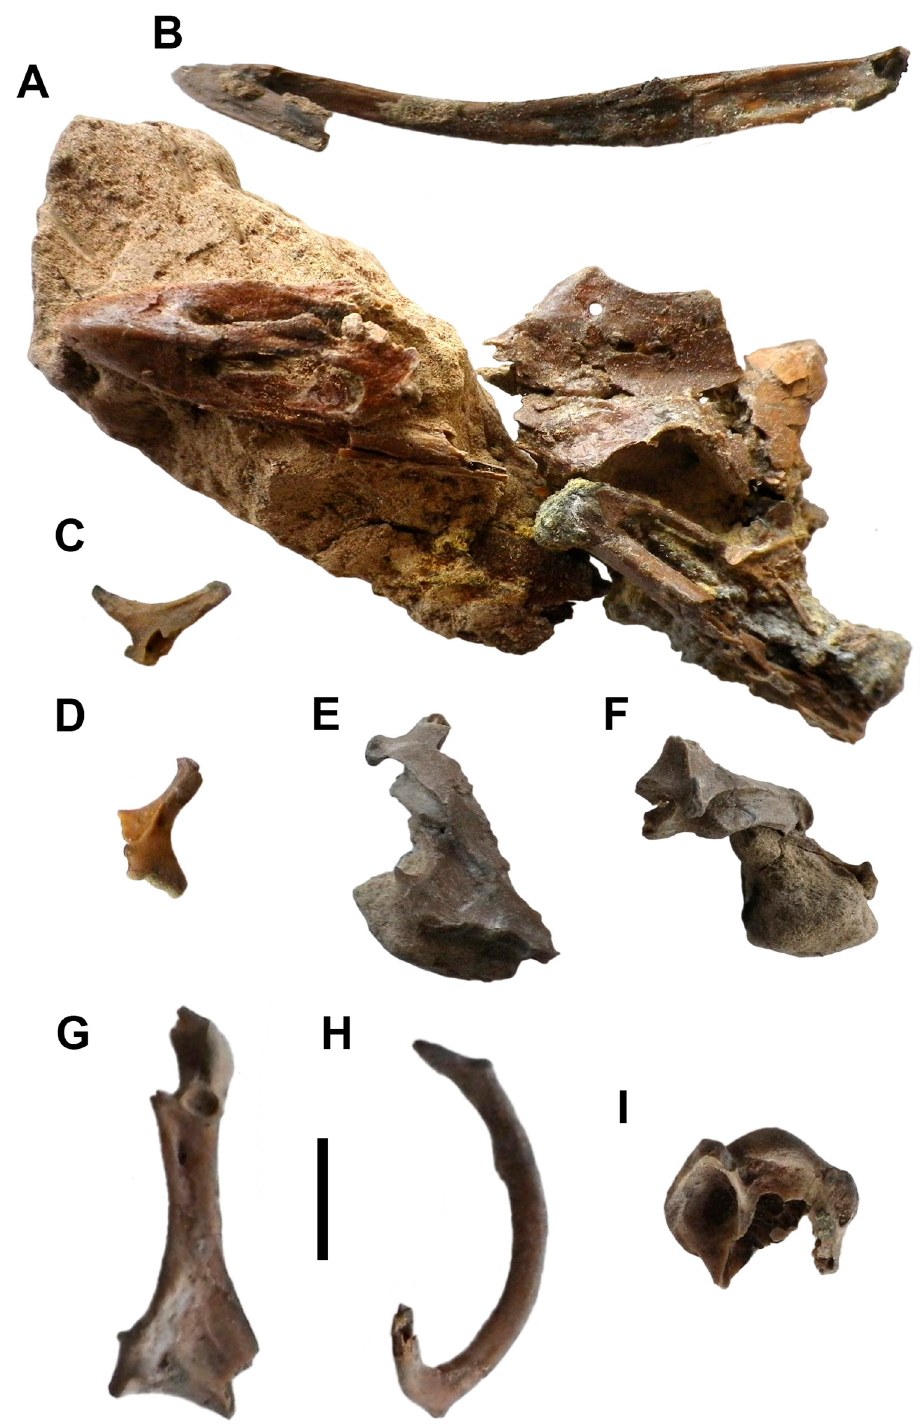
Figure 7. Screamer-like anseriform from the London Clay Formation (NMS.Z.2021.40.2, Anseriformes familia incertae sedis): dorsal aspect of skull in two unattached pieces of matrix ( A ), right ventrolateral mandible ( B ); quadrates, left lateral left ( C ), right medial ( D ); cranial portion of sternum, right ventrolateral ( E ), cranial ( F ); right coracoid, dorsal ( G ); furcula, right craniolateral aspect ( H ); proximal right humerus, caudal ( I ). Scale bar 1 cm. Remarks: NMS.Z.2021.40.2 was illustrated and briefly described by Mayr [26] (pp. Material: skull including supraorbital region and complete upper bill, left side of 60–61, figure 4.10g). mandible including the rostrum, quadrates, five cervical vertebrae, cranial portion